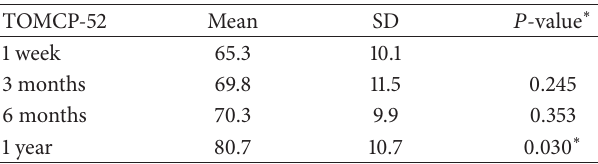
Table 4: Significance of changes in mean TOMCP-52 scores over the study period.